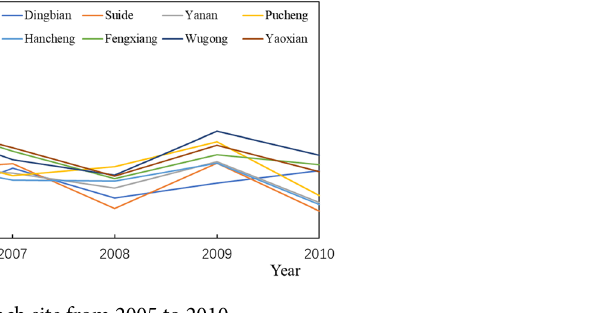
Figure 7. SPI changes at each site from 2005 to